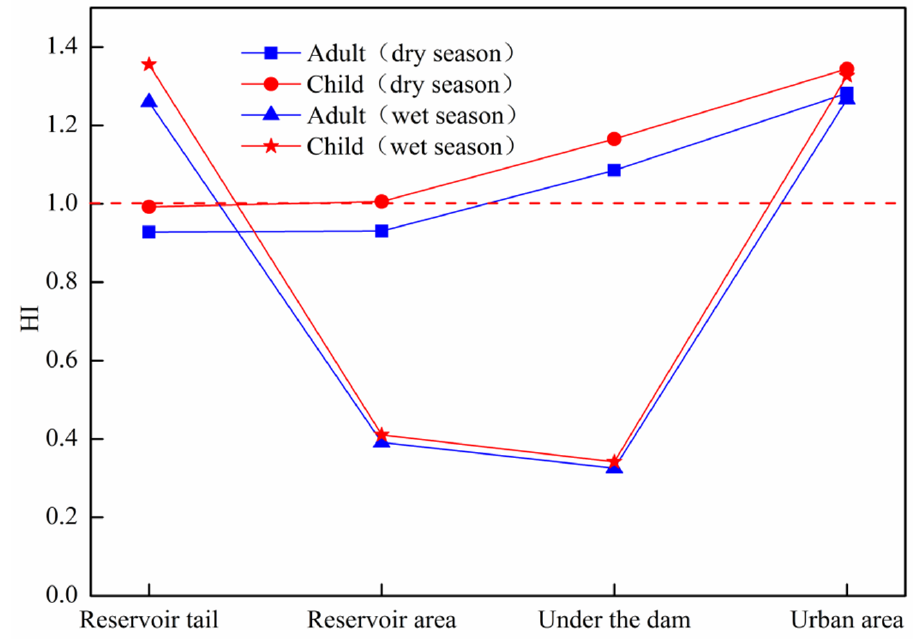
Figure 5. Health risks of trace elements in different regions in upper Lancang River.